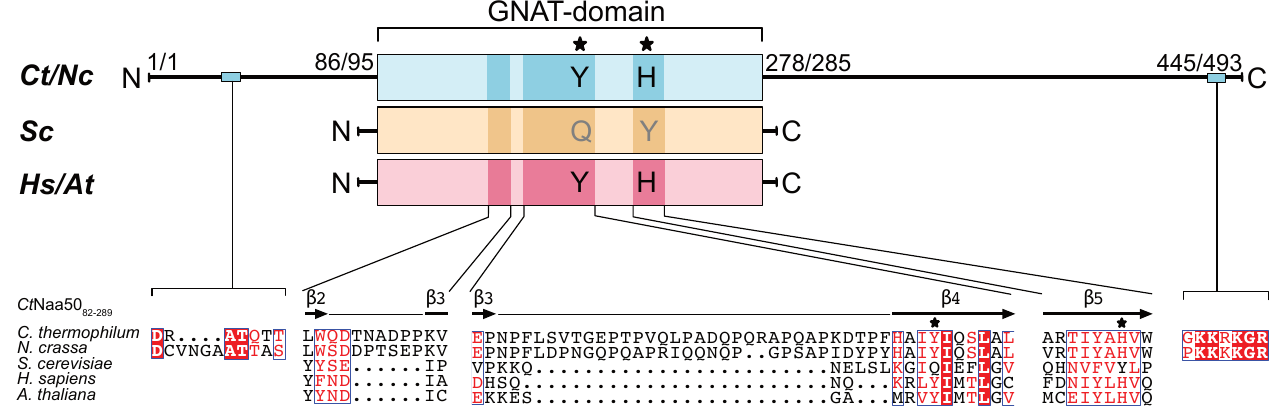
Figure 1. Chaetomium thermophilum and Neurospora crassa Naa50 have N- and C-terminal extensions. Naa50 from C. thermophilum ( Ct ), N. crassa ( Nc) , Saccharomyces cerevisiae ( Sc ), Homo sapiens ( Hs ), and Arabidopsis thaliana ( At ) showed high conservation within the GNAT domain in a multiple sequence alignment. Ct Naa50 and Nc Naa50 (teal) have excessive N- and C-terminal extensions ( Ct Naa50 residues 1-86 and 278-445, and Nc Naa50 residues 1-95 and 285-493, respectively) compared to yeast (yellow) and human/Arabidopsis (salmon) homologs. Secondary structure elements ( β -strands) from a GNAT domain construct Ct Naa50 82-289 are shown on top of the alignment. Ct Naa50 contains a dynein light chain 1 protein binding motif (RxTQT) in the N-terminal extension. Loops β 2– β 3 and β 3– β 4 are longer in Ct and Nc . Ct / Nc Naa50 feature a conserved positive patch KK(R/K)KgR at the C-terminus. Tyrosine and histidine residues ( (cid:70) ) are catalytic residues and are absent in yeast. The sequence alignment was performed using Clustal Omega and visualized using ESPript 3.0 [56,57]. Fully conserved residues are represented as white letters in red boxes. Similarities are shown with red letters in blue